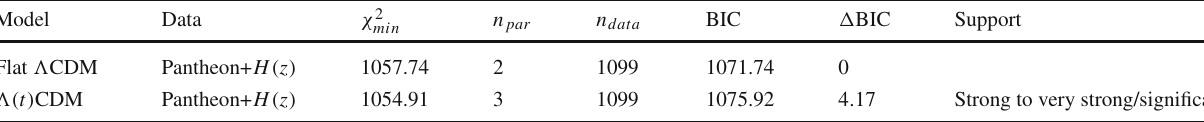
Fig. 6 Combined constraints from Pantheon+ H ( z ) +Planck18(XCDM prior)+BAO on DM-DE interacting model with w (cid:4)= − 1 Table 4 BIC comparison for Pantheon+ H ( z ) data